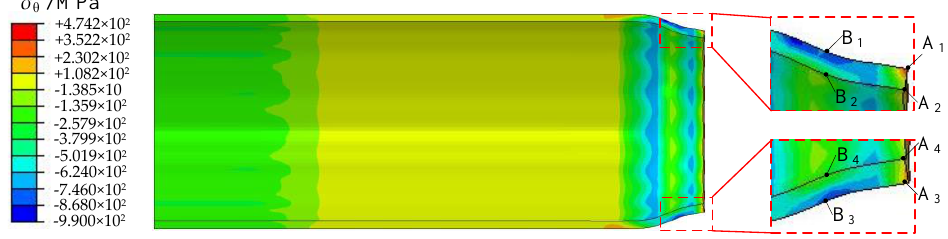
Figure 20. Bending stage.